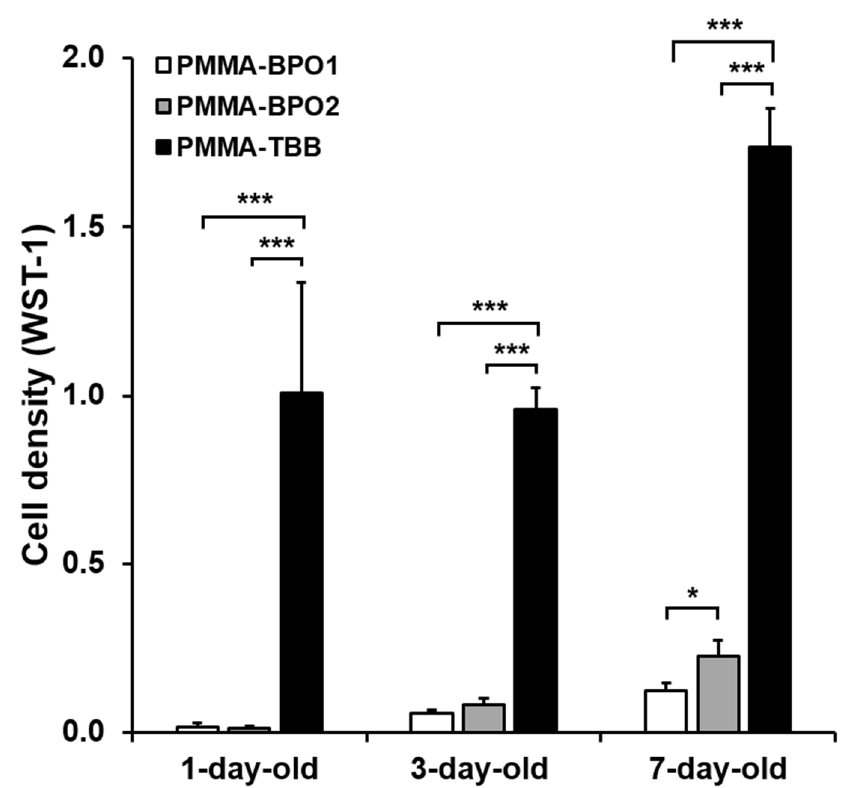
Figure 3. Proliferation activity of osteoblasts on different bone cement types of different ages as evaluated by the WST-1 assay on day five of culture. Data are shown as mean ± SD ( n = 3). Statistical differences between the three groups are shown (two-way ANOVA followed by Bonferroni test, * p < 0.05, *** p < 0.001).